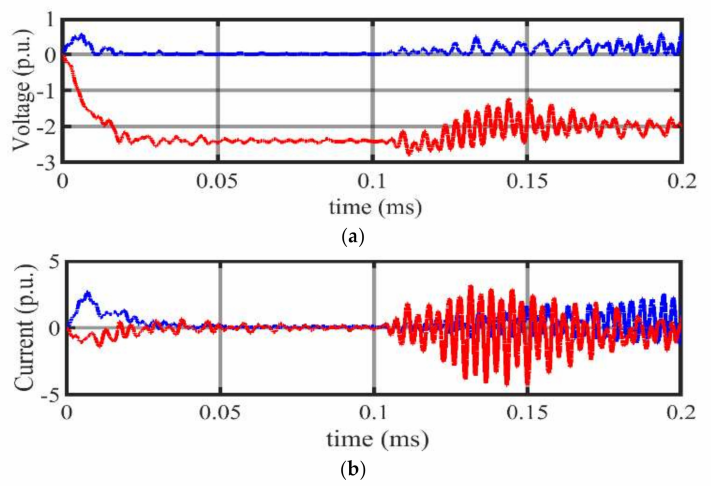
Figure 21. ( a ) DC Voltage and ( b ) DC current profiles under PPG fault occurred at 100 km from RS-I on Line 1.